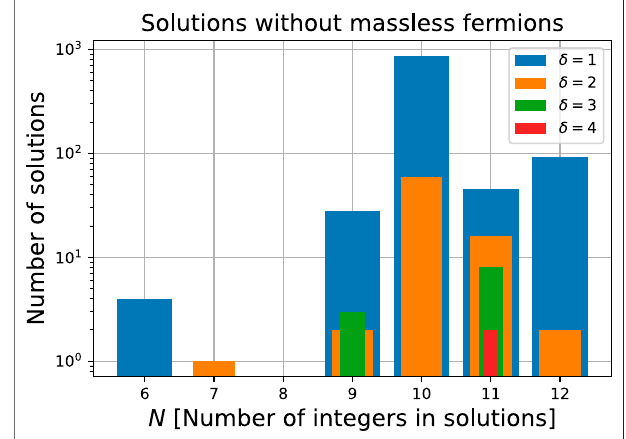
FIGURE 1 | Distribution of solutions with N integers to the Diophantine Eq.1 whichallowtheeffectiveDiracneutrinomassoperatorat d =(4+ δ )forat least two right-handed neutrinos and have non-vanishing Dirac o Majorana masses for the other SM-singlet chiral fermions in the